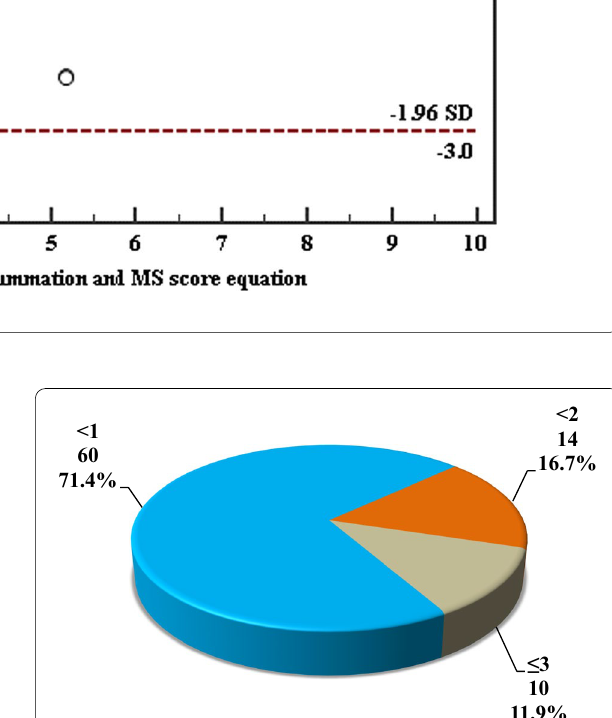
Indahl et al. noted that the injection of saline into the zygapophyseal joint in a porcine model resulted in decreased activity of the multifidus muscle. They con- cluded that the effect of the injection was to activate a stretch reflex in the joint capsule, which in turn excited inhibitory interneurons in the spinal cord [12].